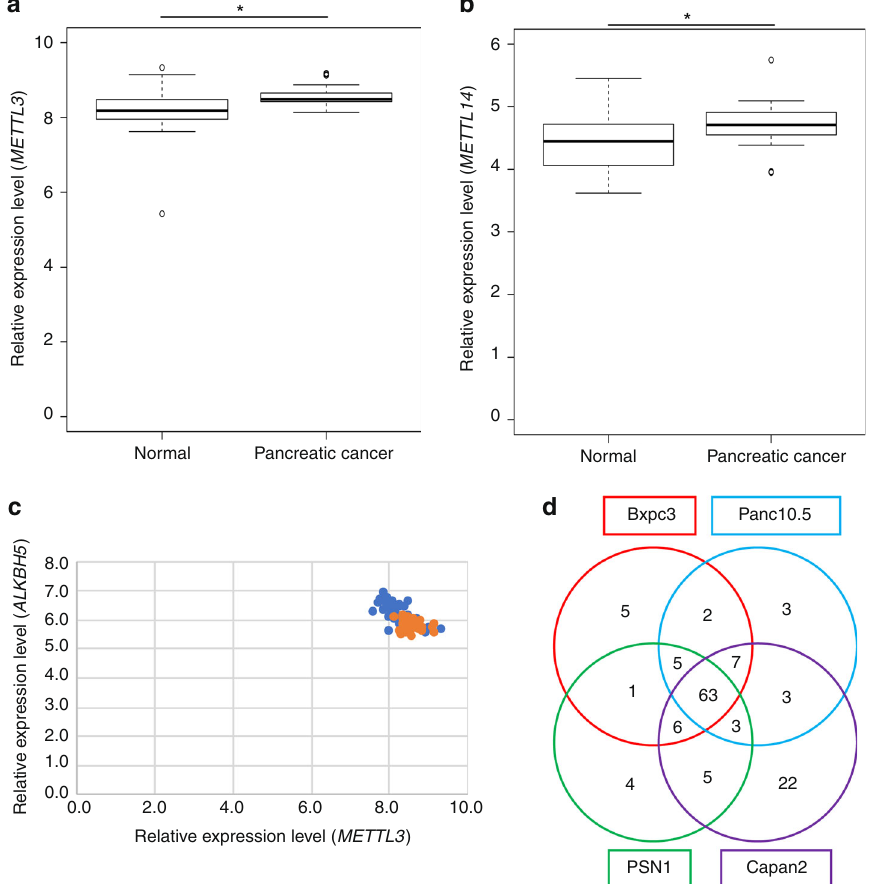
Fig. 1 Methylated miRNAs are tended to upregulated in gastrointestinal cancer. a Analysis of RNA expression levels of the RNA methylases METTL3 using a Gene Expression Omnibus (GEO) dataset (GDS4103) derived from pancreatic cancer and paired normal tissue samples from 36 patients. * p = 7.68 × 10 − 5 (Wilcoxon ’ s t test). b Analysis of RNA expression levels of the RNA methylase METTL14 using a Gene Expression Omnibus (GEO) dataset (GDS4103) derived from pancreatic cancer and paired normal tissue samples from 36 patients. * p = 0.007193 (Wilcoxon ’ s t test). c Analysis of the correlation between METTL3 and ALKBH5 expression levels. Blue and orange points represent normal tissue and Pancreatic cancer tissue, respectively. R value was − 0.68 in normal tissue and − 0.19 in pancreatic cancer. d Methylated miRNA analysis by RIP-Seq using an anti-m6A antibody. The Venn diagram shows that 63 methylated miRNAs were common to four pancreatic cancer cell lines. The box range means from the fi rst quartile to the third quartile. The second quartile means the median of the data. The lower limit of the bar was estimated by “ the fi rst quartile − 1.5 × interquartile range ” , and the upper limit of the bar was estimated by “ the third quartile + 1.5 × interquartile range